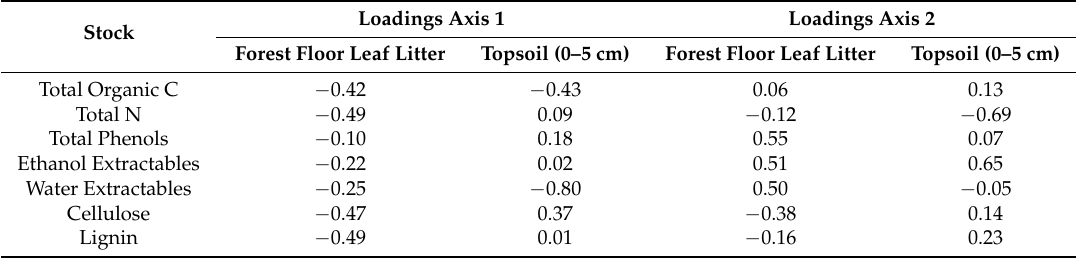
Table 4. Loading of the two-block PLS in the first two axes. Absolute higher values within each block (forest floor leaf litter or topsoil) imply the stronger importance of the variable. Among and between blocks, variables that have the same sign are positively correlated and inversely correlated when the sign is